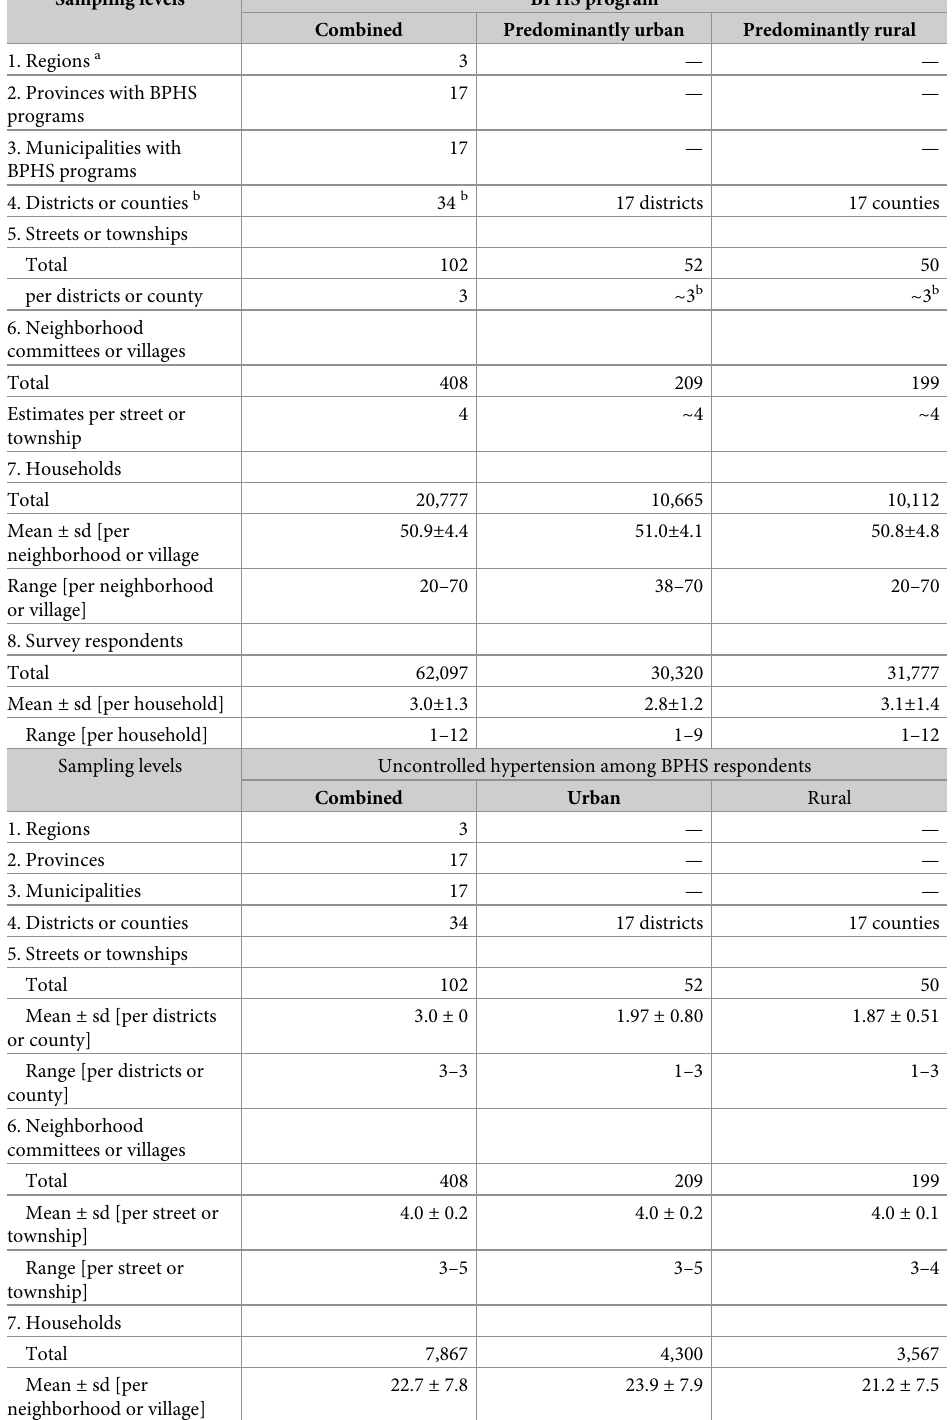
Table 1. Sampling schemes for the CHSIS survey [A] and sampling levels for the analysis of Uncontrolled Hyper- tension [B]. [A] Sampling design for the CHSIS survey. [B] Sampling levels in the analysis of Uncontrolled Hyper- tension. The sampling scheme for the current study of Uncontrolled Hypertension [B] is derived from the survey design for the BPHS survey